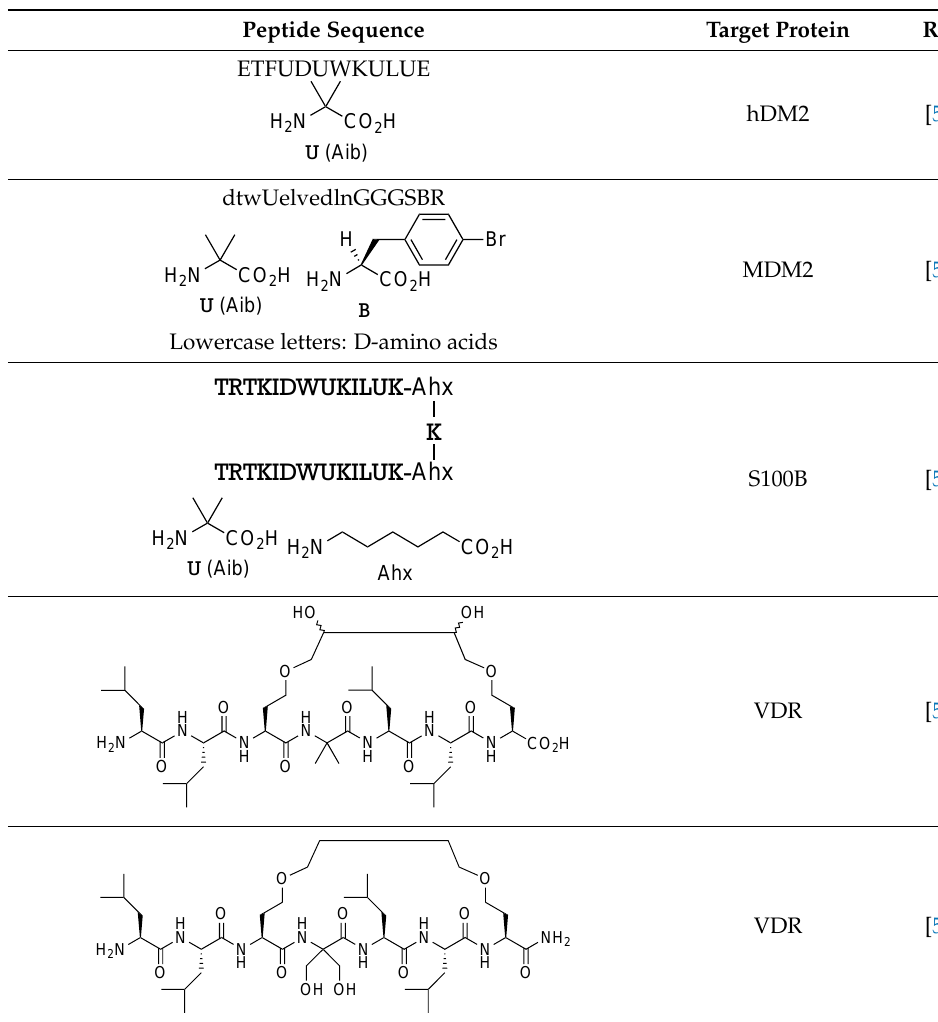
Table 1. α -Peptide PPI inhibitors that contain dAAs. Peptide Sequence